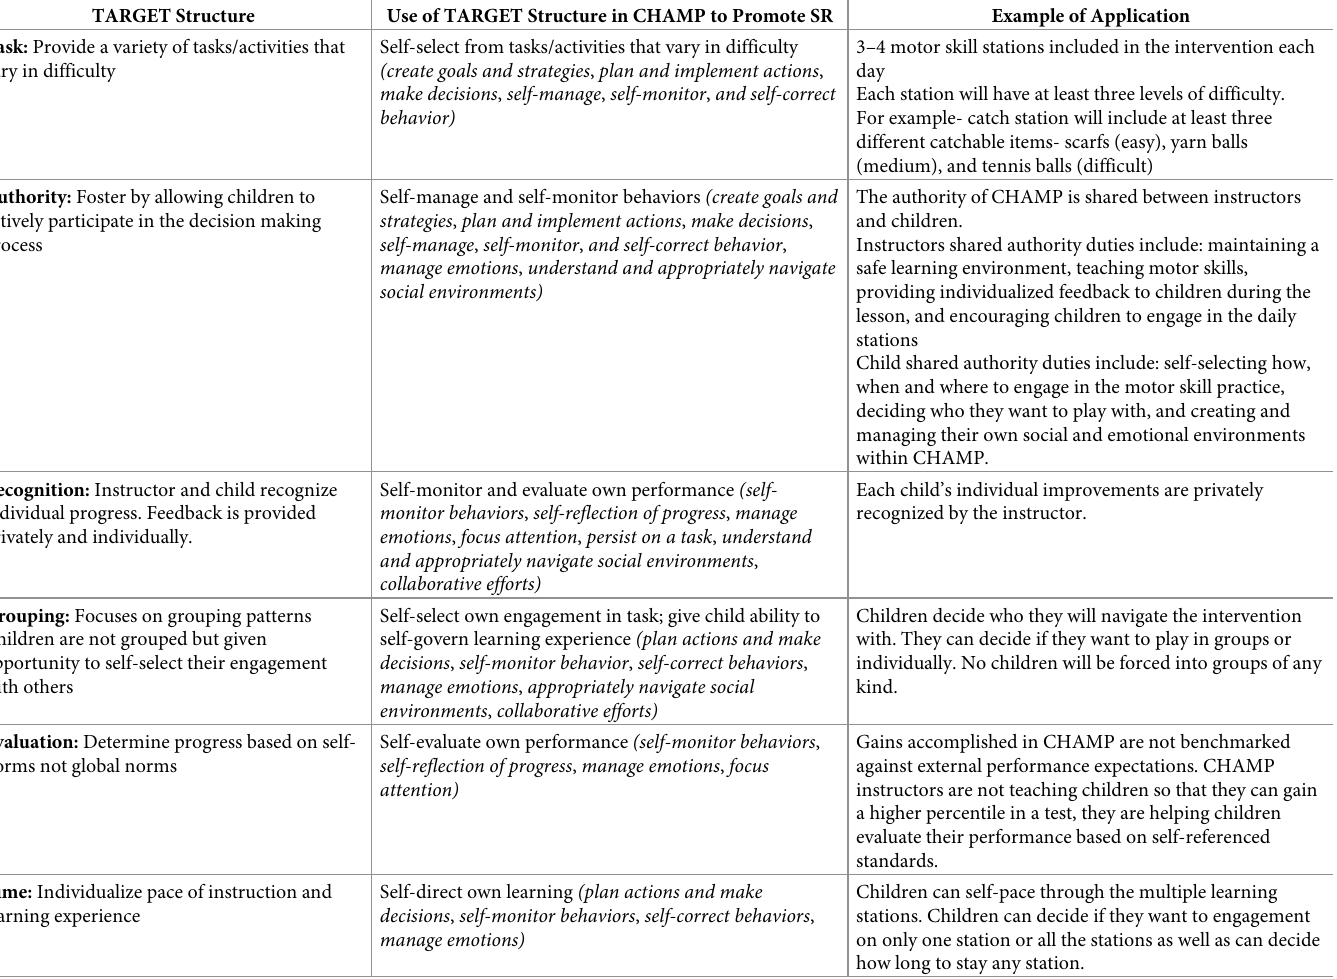
Table 1. Foundations of CHAMP intervention and links to